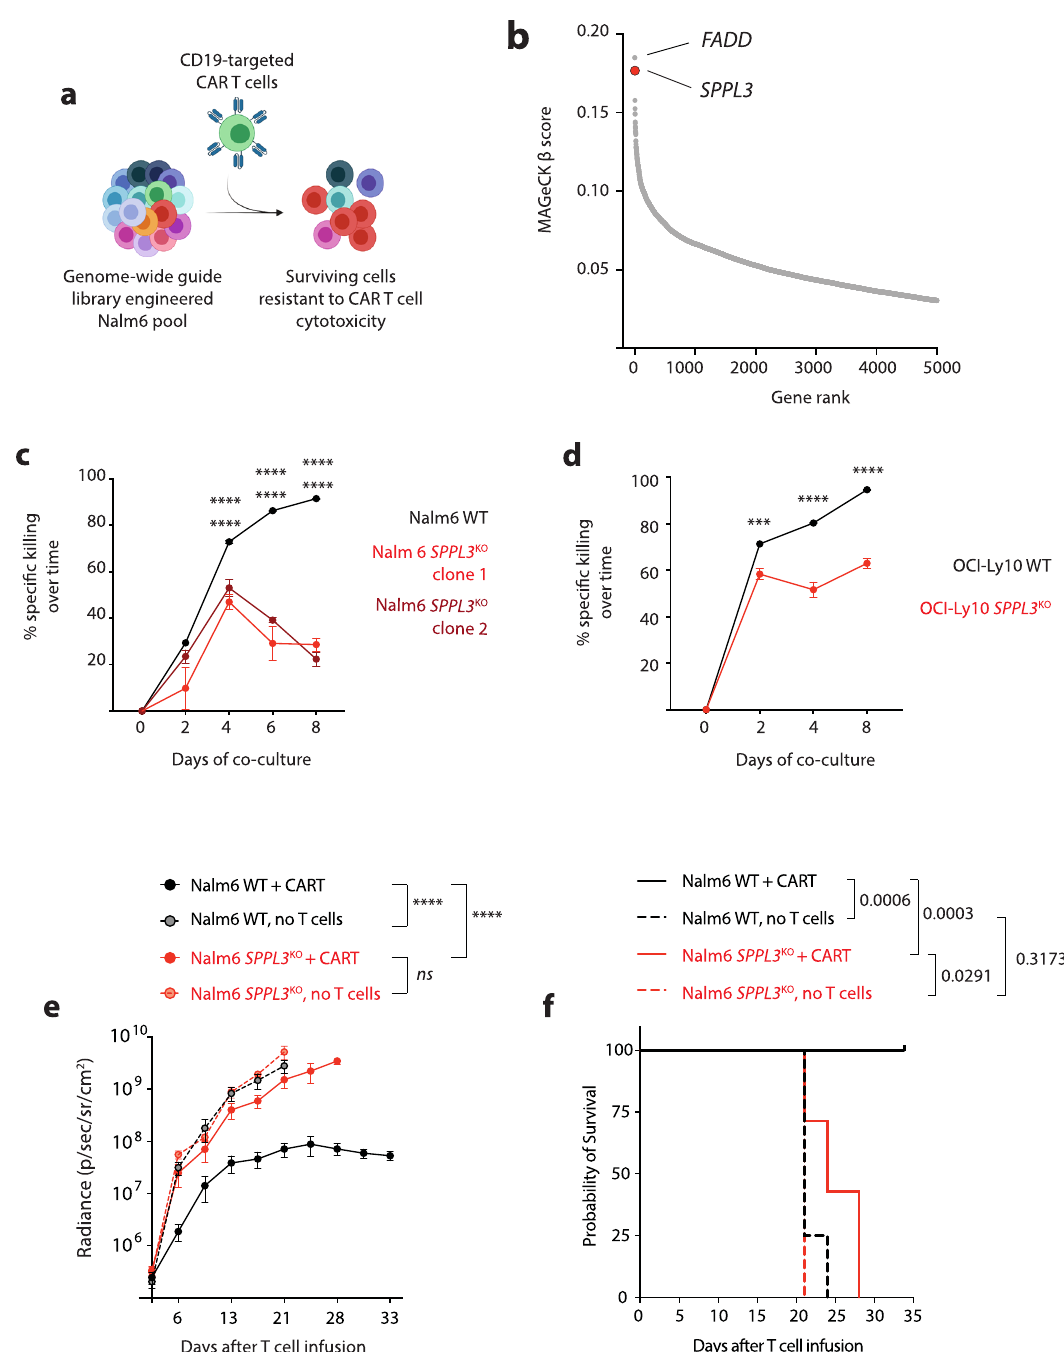
Fig. 1 Loss of SPPL3 results in resistance to CD19-directed CAR T cells. a Schematic of the genome-wide knockout screen in Nalm6 ALL. b Plot of MAGeCK beta scores for genes that were enriched in CART19 targeted cells compared to untargeted T cells. c Survival of Nalm6 and d OCI-Ly10 over time after combination with CART19 (E:T ratio 0.25:1). e Tumor radiance over time and f Survival of NSG mice treated engrafted with either WT or SPPL3 KO Nalm6 after treatment with CART19 cells ( n = 7 per group) or no treatment ( n = 4 per group). *** P < 0.001, **** Error bars re fl ect mean ± standard error of the mean (s.e.m.). P < 0.0001 by two-way ANOVA with Bonferroni correction for multiple comparisons. Survival analyses were performed with the log- rank test. Data were representative of n = 5 ( c , d ) individual experiments with distinct donor T cells. In c statistical annotations re fl ect differences between WT and SPPL3 KO clone 1 (upper) and WT and SPPL3 KO clone 2 (lower). Source Data are provided as a Source Data fi